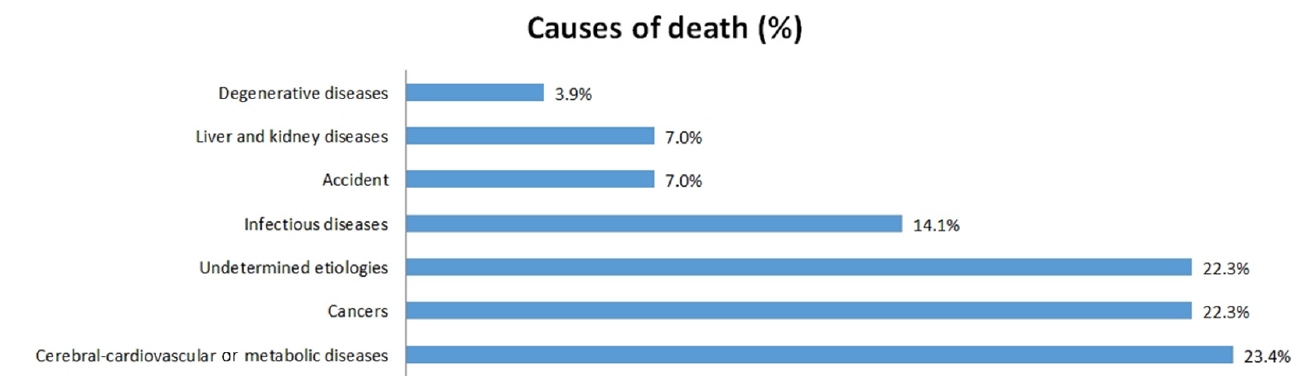
Figure 2. Causes of death in patients who had discontinued anti-osteoporosis medication.